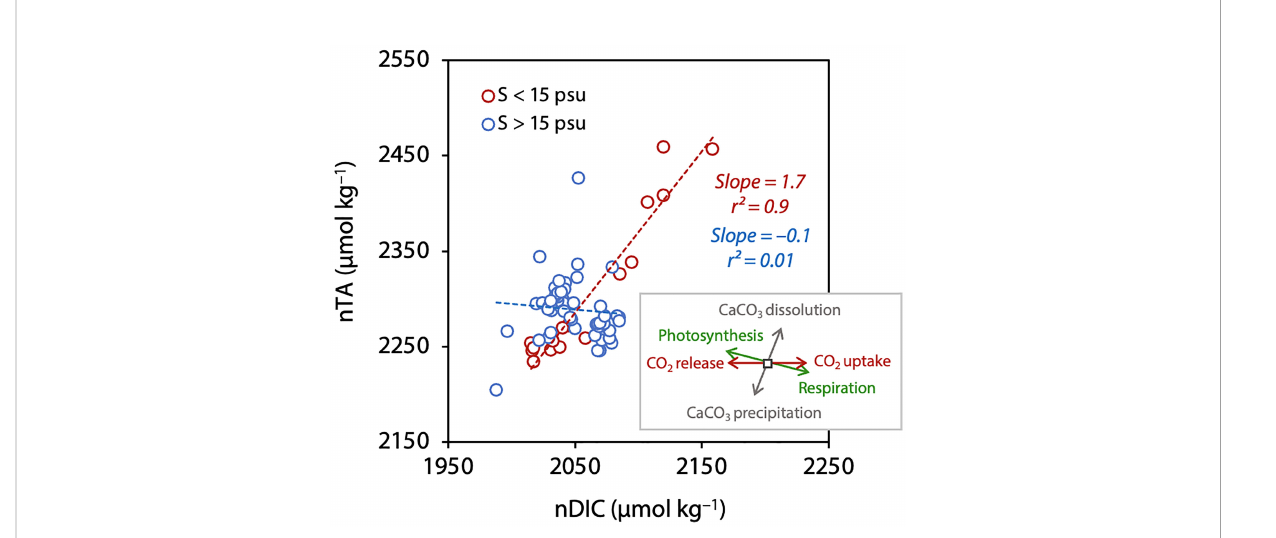
FIGURE 7 Relationships between nTA and nDIC for S > 15 psu (blue) and S < 15 psu (red). Dashed lines indicate the regression lines for each salinity category. The inset indicates the theoretical slope of the different processes affecting n-DIC and